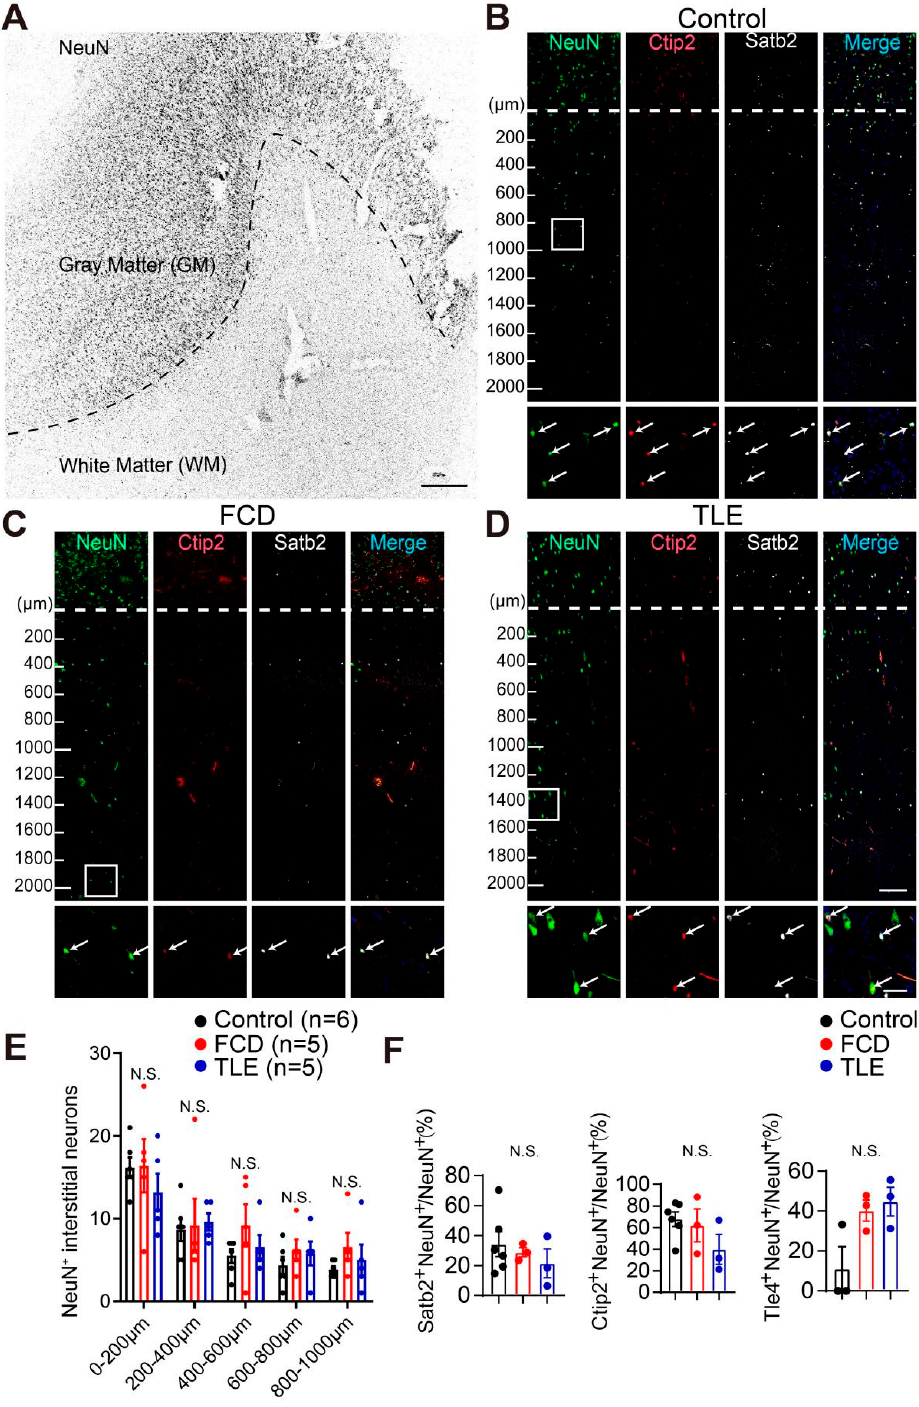
Figure 1. The distribution of cortical layer markers in interstitial neurons in the white ma tt er of brain tissues from FCD, TLE, and control. ( A ) Tile scan image showing the distribution of NeuN-positive neurons in the gray ma tt er and white ma tt er of the frontal lobe of adult control human brain. A dashed line indicates the border between gray ma tt er and white ma tt er. The rectangular box indi- cates the image acquisition area in panel ( B ). Scale bar, 1000 µm. ( B ) Tile scan images showing the distribution of interstitial neurons expressing cortical layer markers in the white ma tt er of brain tissues from control, FCD ( C ), and TLE ( D ). Arrows indicated co-expression of cortical layer markers